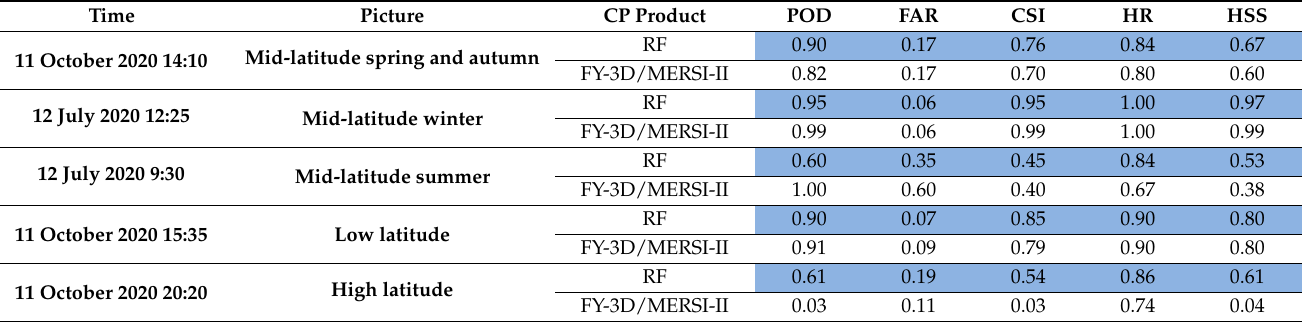
Table 5. Statistics for the performance metrics of CP classification when comparing RF CP product and operational FY-3D/MERSI-II CP product, based on images from five time periods representing five categories of season and latitude. Time Picture CP Product POD FAR